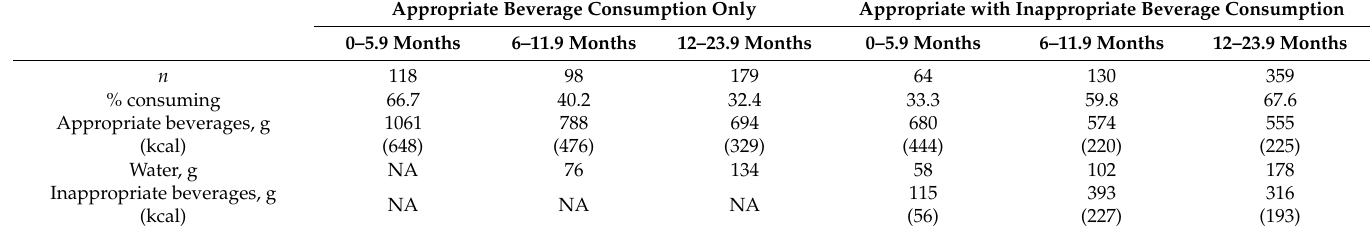
Table 2. Amounts (g) and energy (kcal) per capita provided by appropriate and inappropriate milk and beverages among Mexican infants and toddlers from ENSANUT 2012.